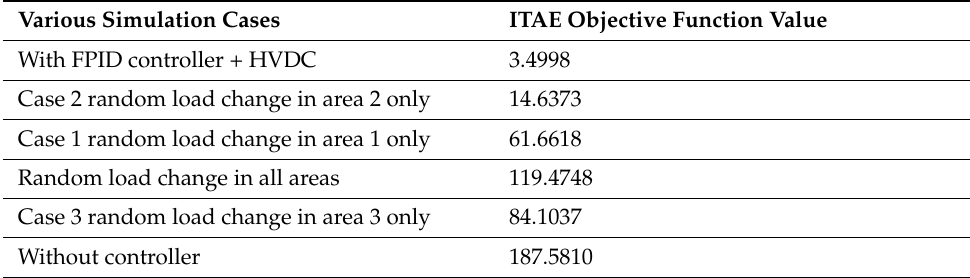
Table 8. ITAE cost function for different loading and controller